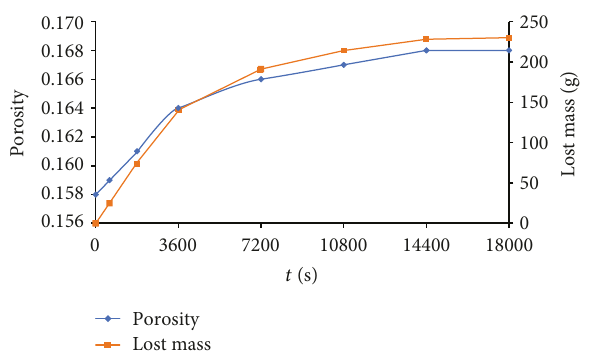
Figure 9: Time-varying curves of porosity and lost mass obtained using the genetic